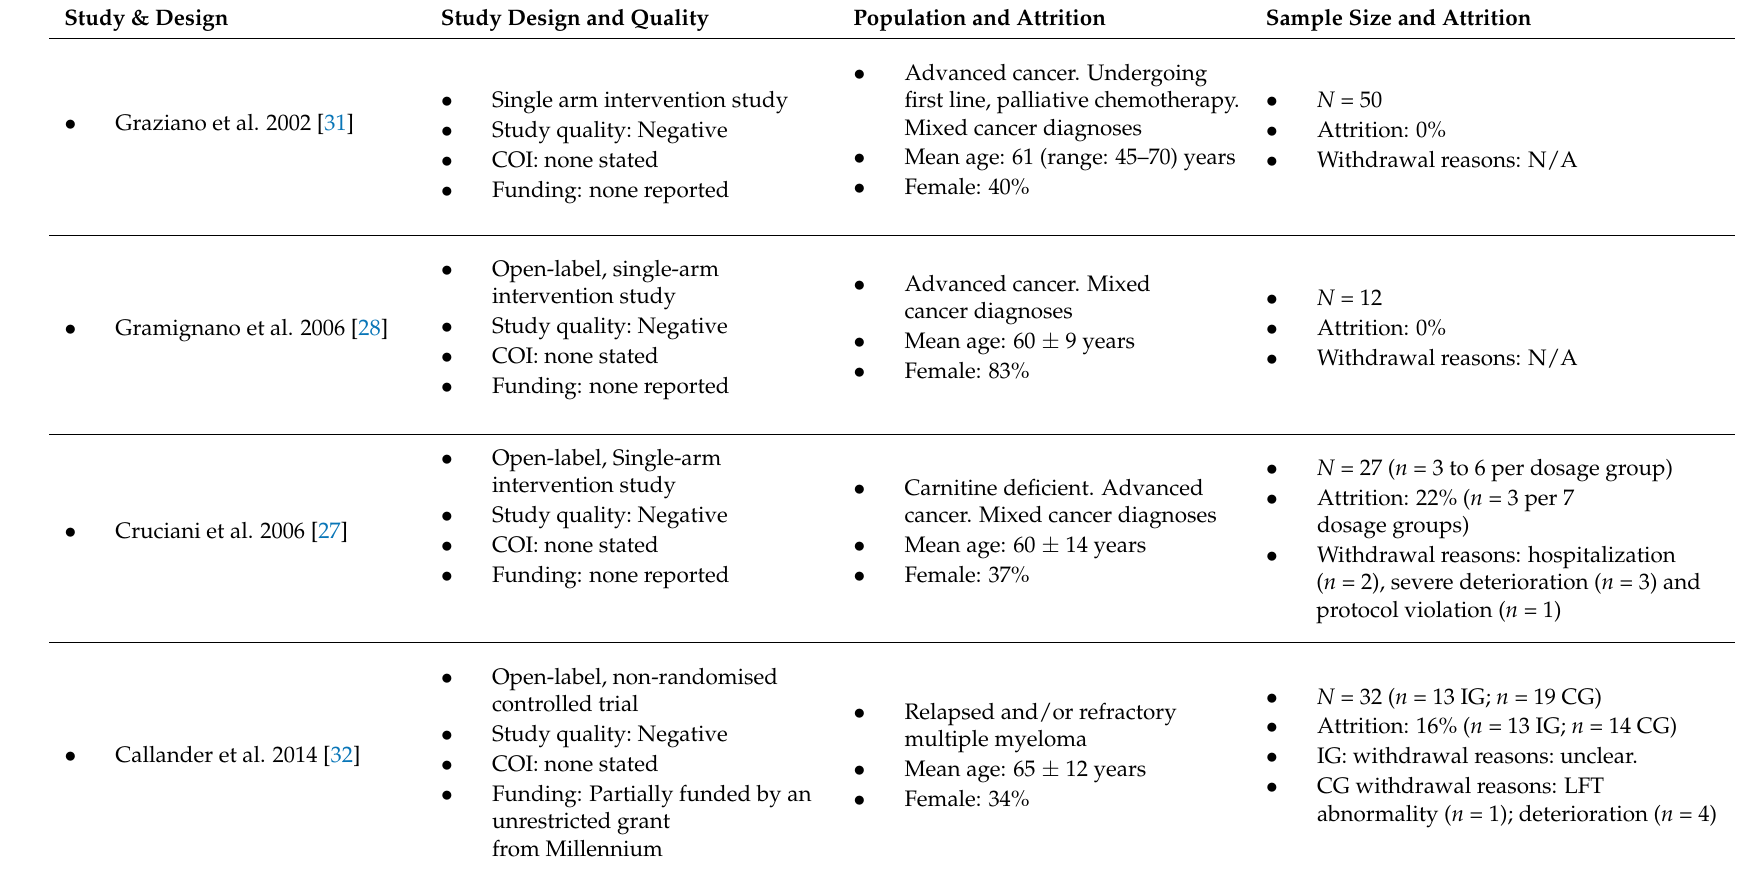
Table 1. Study Design, Population and Quality of Included